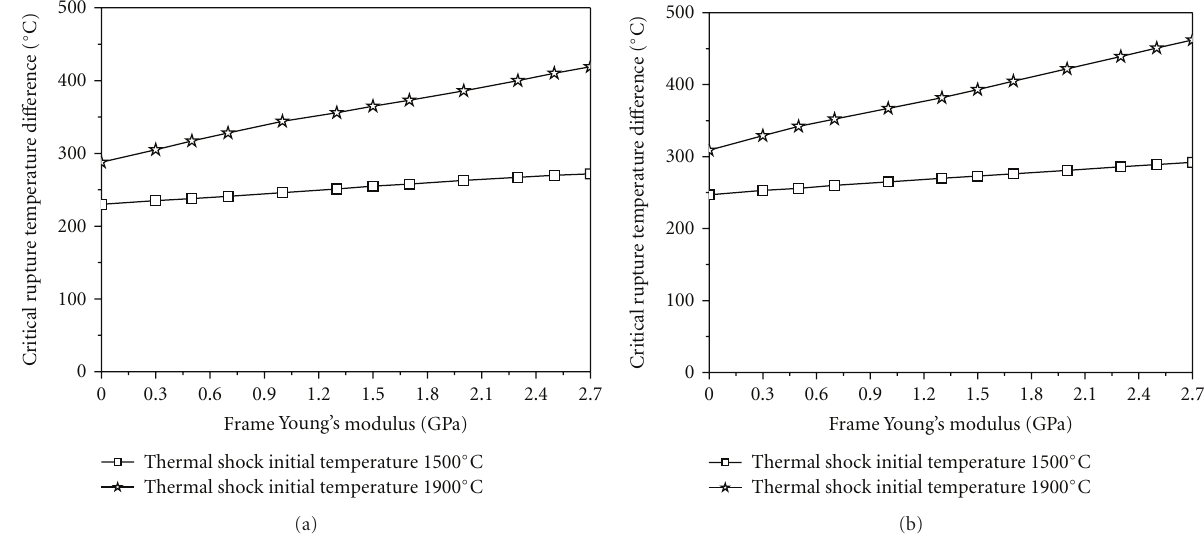
Figure 7: The critical rupture temperature di ff erence versus frame Young’s modulus for di ff erent thermal shock initial temperature with the same cooling rate (a) 320 ◦ C · s − 1 and (b) 2000 ◦ C · s − 1